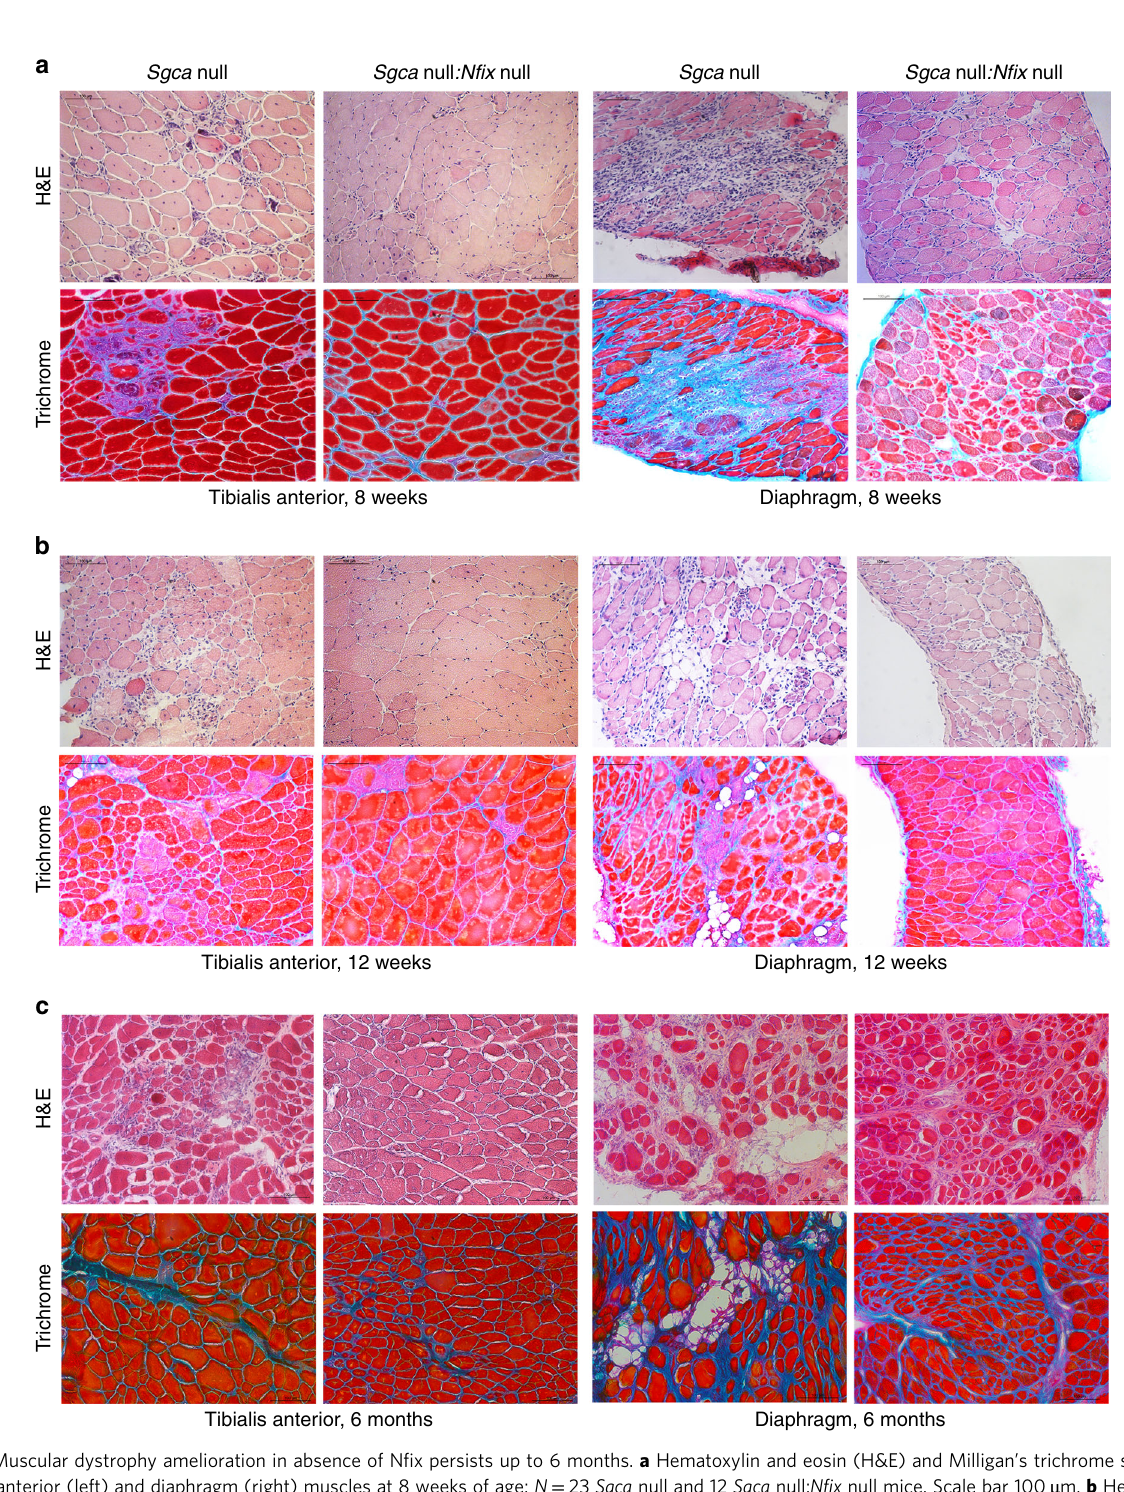
Fig. 2 Muscular dystrophy amelioration in absence of N fi x persists up to 6 months. a Hematoxylin and eosin (H&E) and Milligan ’ s trichrome staining of tibialis anterior (left) and diaphragm (right) muscles at 8 weeks of age; N = 23 Sgca null and 12 Sgca null: N fi x null mice. Scale bar 100 μ m. b Hematoxylin and eosin (H&E) and Milligan ’ s trichrome staining of tibialis anterior (left) and diaphragm (right) muscles at 12 weeks of age; N = 6 Sgca null and 4 Sgca null: N fi x null mice. Scale bar 100 μ m. c Hematoxylin and eosin (H&E) and Milligan ’ s trichrome staining of tibialis anterior (left) and diaphragm (right) muscles at 6 months of age; N = 4 Sgca null and 4 Sgca null: N fi x null mice. Scale bar 100 μ m. See also Supplementary Fig. 1 for the analysis of central nucleation in tibialis anterior and diaphragm muscles at 8 and 12 weeks and for the analysis of CSA at 8 weeks, Supplementary Fig. 2 for full muscle reconstructions, collagen I quanti fi cation, histology of gastrocnemius, quadriceps, soleus, and EDL muscles, and PCR analysis of oxidative fi ber genes at 8 weeks, and Supplementary Fig. 3 for the analysis of utrophin and myostatin levels at 8